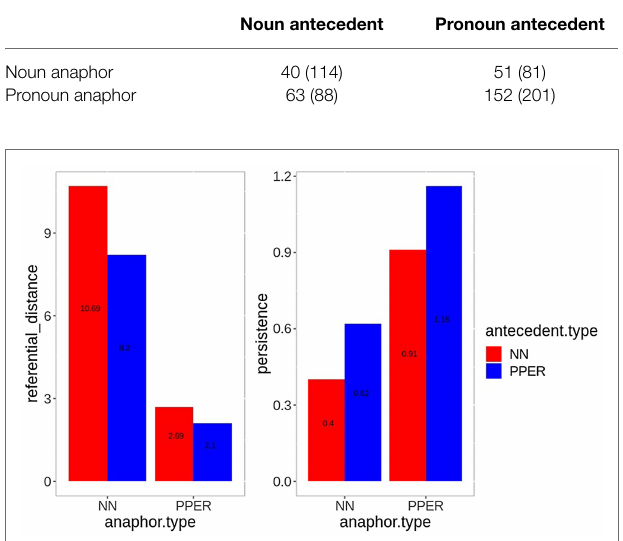
FIGURE 1 | Mean referential distance (left) and persistence (right) for all noun (red) and pronoun (blue) anaphors in the audio book recording by antecedent